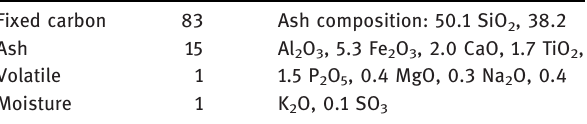
Table 1: Compositions of industry coke (%mass) Fixed